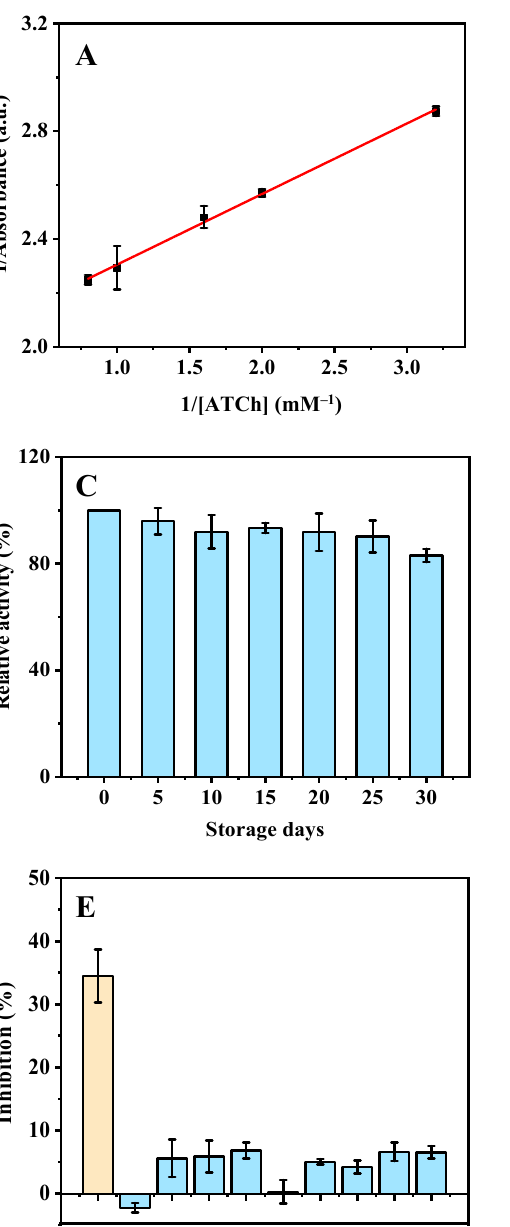
TNB) (Figure 5A). The K m (0.1 mM) was calculated via the slope and intercept and differs from that of natural AChE (1.2 mM [12] and 1.0 mM [13]).